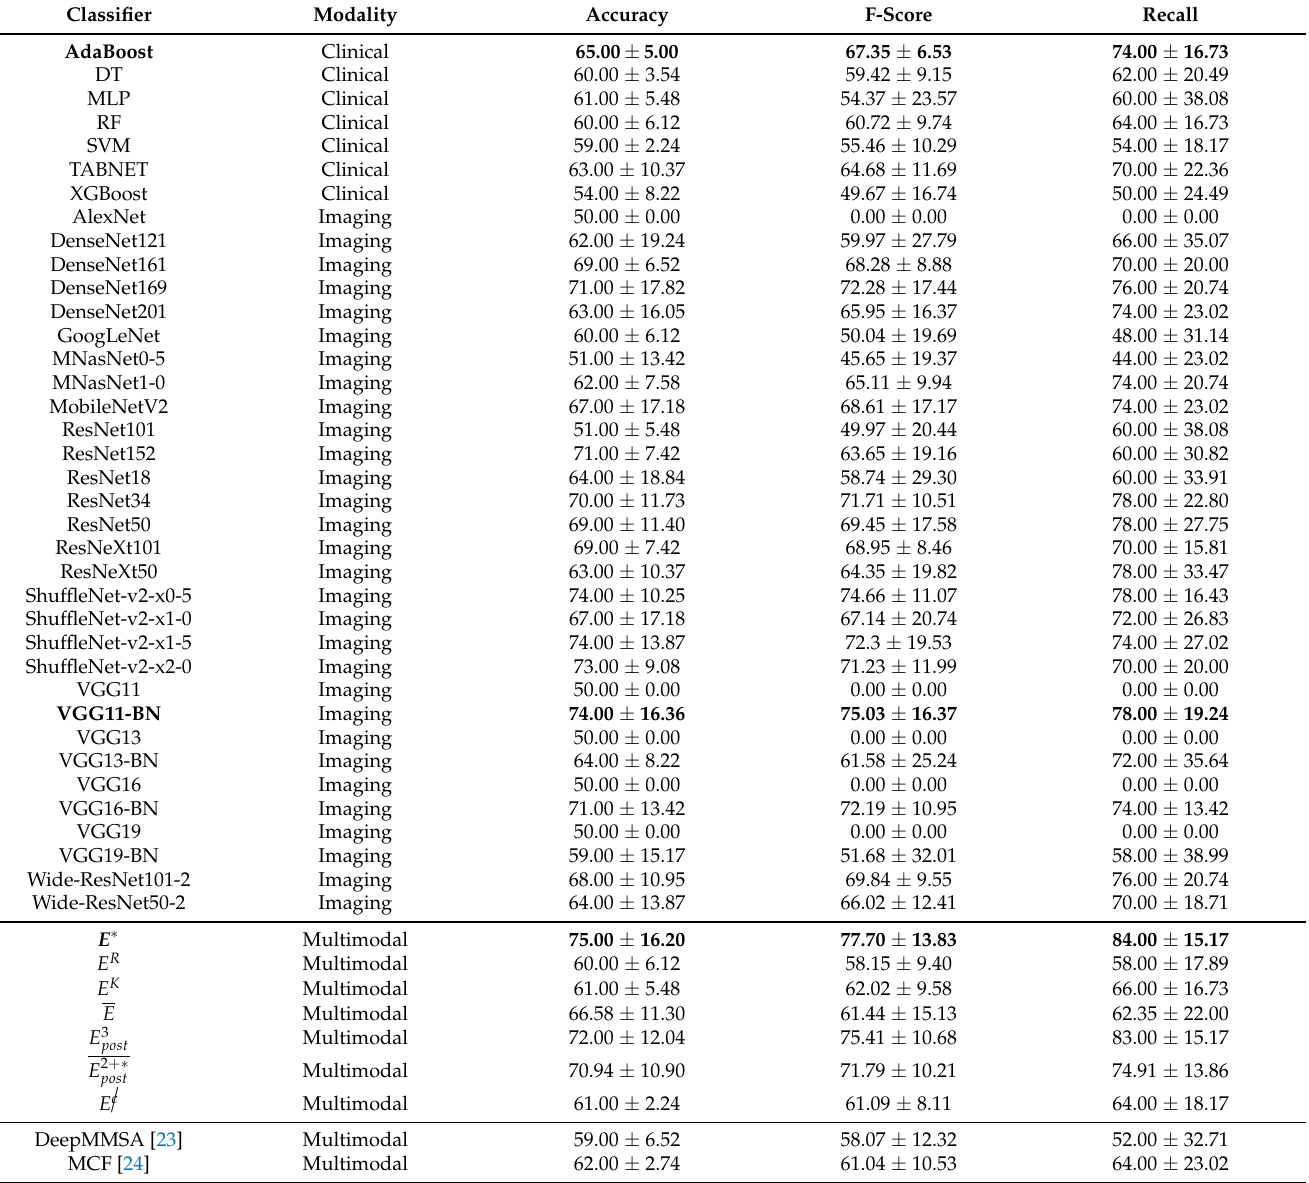
Table 3. Performance of all the tested models with the best for each modality reported in bold. Each column shows the mean value of a performance metric followed by the standard deviation. E ∗ is our optimum ensemble; E R and E K are the ensembles which maximise R and K , respectively; E is the average performance for all the possible ensembles; E 3 is the ensemble consisting of the unimodal post models with the largest recall, E 2 + ∗ is the ensemble with the two unimodal classifiers with the largest post recall per modality whilst varying the remaining experts included in the ensemble; E (cid:3) c is the ensemble obtained relaxing the multimodality